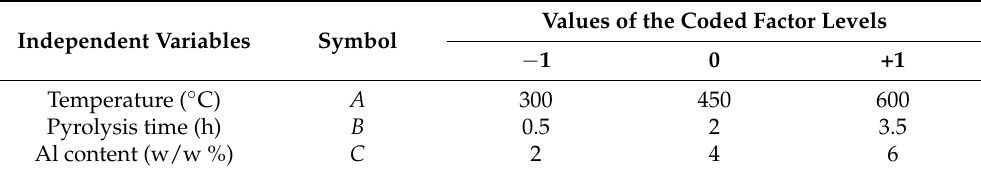
Table 1. Box–Behnken design: list of independent variables and levels. Independent